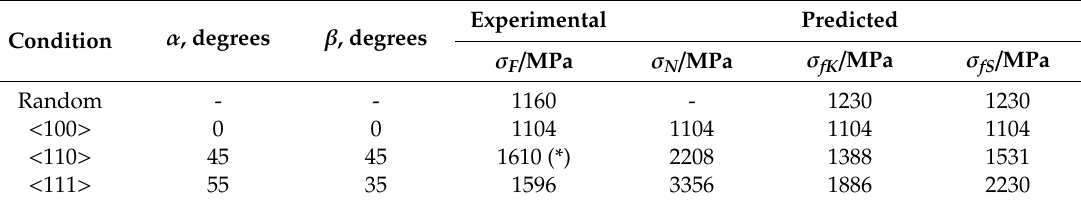
Table 5. Experimental and predicted values of the fracture strength of tensile specimens tested at − 196 ◦ C of Fe20Cr4.5Al in di ff erent